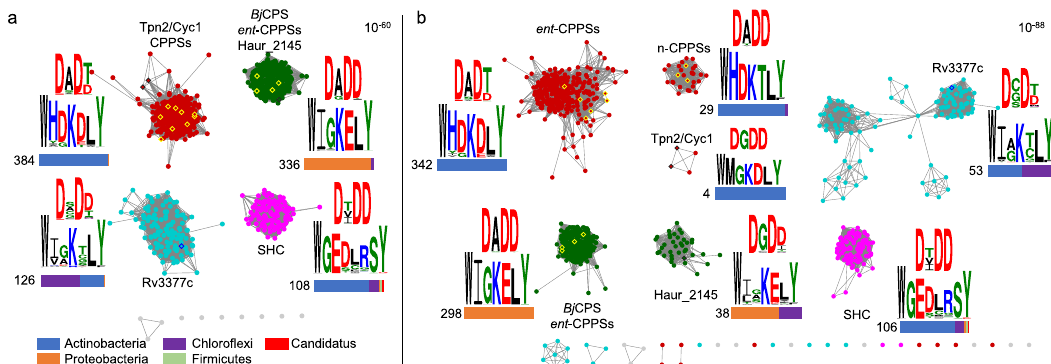
Fig. 4 Bioinformatics of bacterial type II TSs. The 964 identi fi ed type II TSs separate into four major families in an SSN at an e-value of 10 − 60 ( a ) and six major families at an e-value of 10 − 88 ( b ). Functionally characterized TSs producing labdane (yellow), clerodane (black), or halimane (blue) are outlined. Sequence logos highlighting the conservation of the DxDD and Asp/Gly-containing motifs are shown. The number of TSs in each family and taxonomic distributions are shown below the sequence